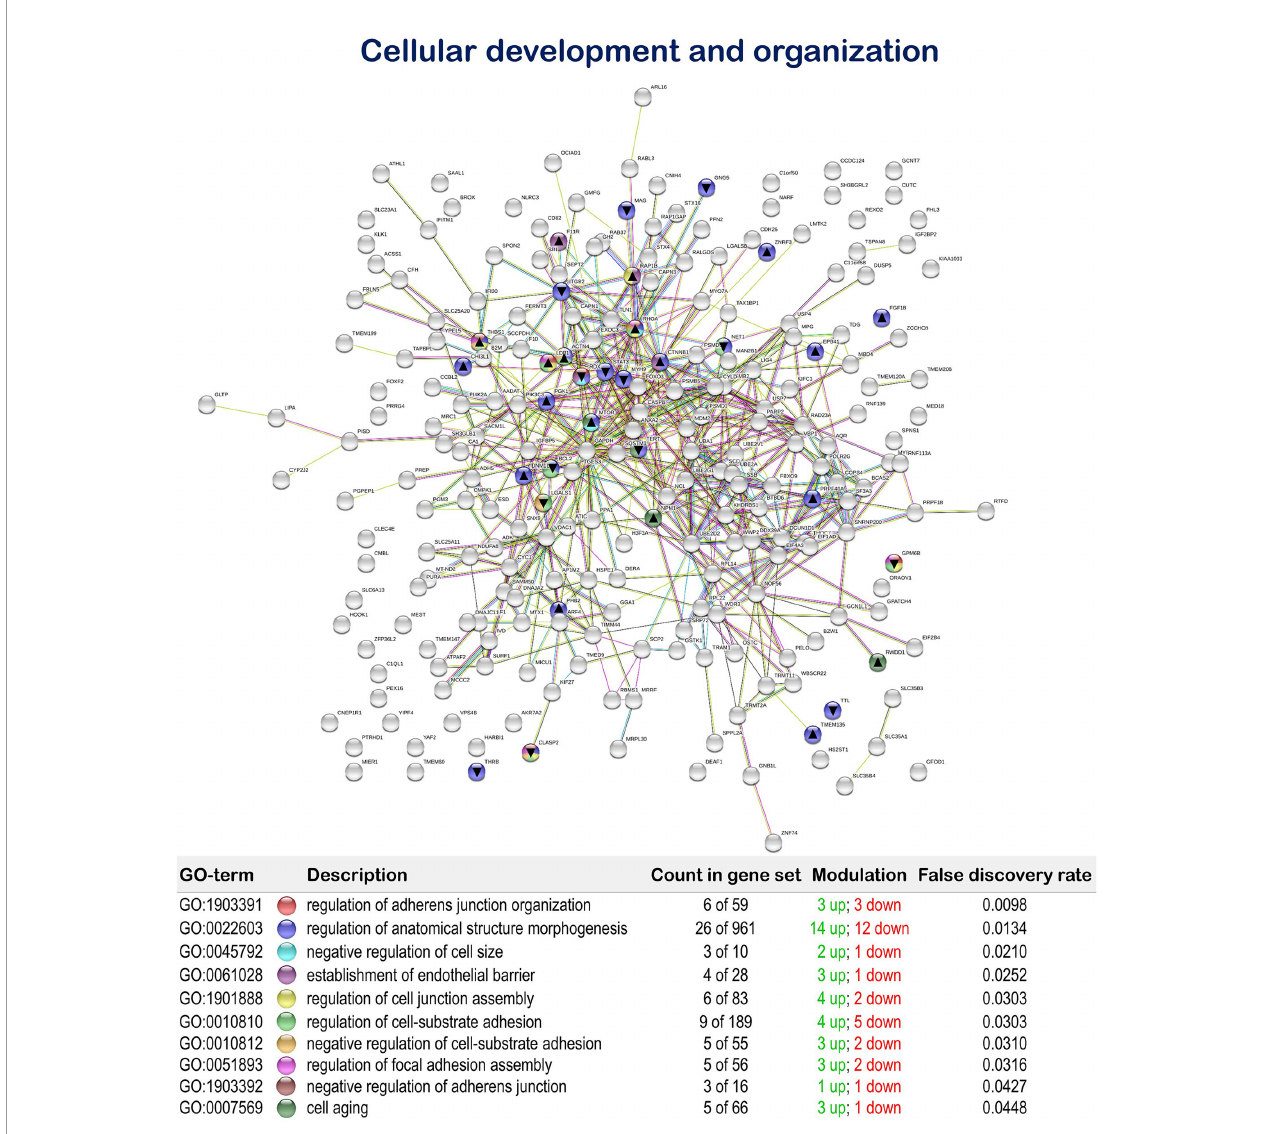
FIGURE 6 | Cellular development and organization related Protein-Protein Interactions Network (PPI) network of the differentially expressed genes (DEGs) in the mid- anterior intestine of juvenile gilthead seabream ( Sparus aurata ) fed the mixture of MPLE obtained from sage ( S. of fi cinalis ) and lemon verbena ( L. citriodora ) (see also Supplementary Table 4 ). Nodes colors indicate the biological processes for each DEG represented. Gene Ontology (GO) de fi nitions, count of DEGs within each biological processes and respective false discovery rate are described in the graphical fi gure legend. ▲ nodes represent up-regulated genes and ▼ nodes represent down-regulated genes. Graphic keys and network stats are indicated in the graphical fi gure legend. Network Stats: number of nodes: 243; number of edges: 550; average node degree: 4.53; avg. local clustering coef fi cient: 0.416; expected number of edges: 423; PPI enrichment p-value: 1.98e-09. The MPLE included in the basal diet was obtained from sage ( Salvia of fi cinalis ) and lemon verbena ( Lippia citriodora